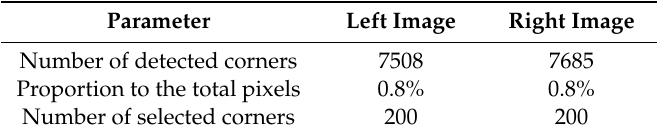
Table 10. Results of Harris corner detection on target object in the out-of-water